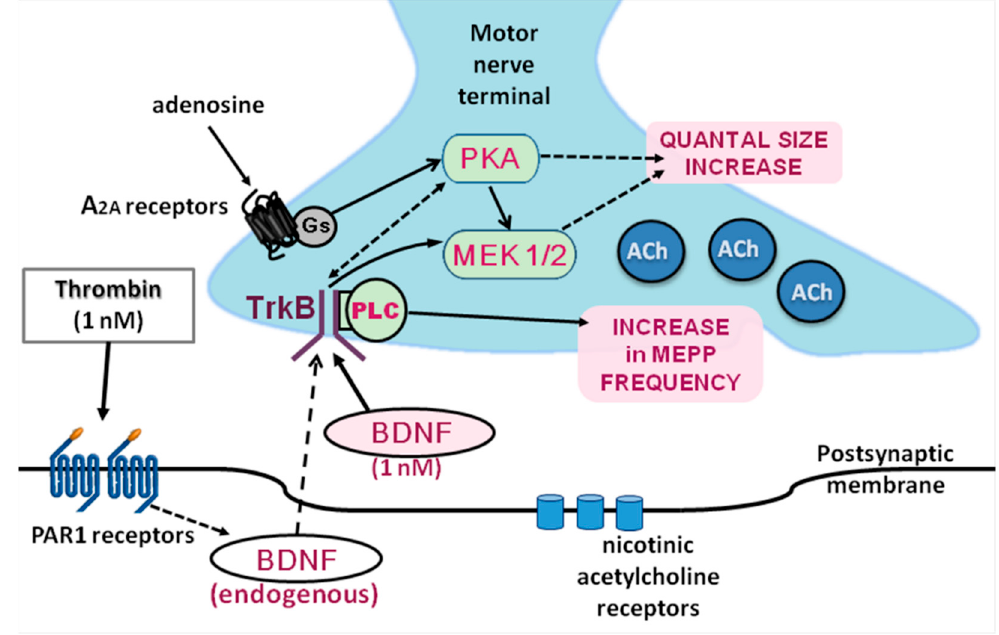
Figure 13. Suggested signaling pathways underlying the potentiating action of thrombin and BDNF at NMJs.